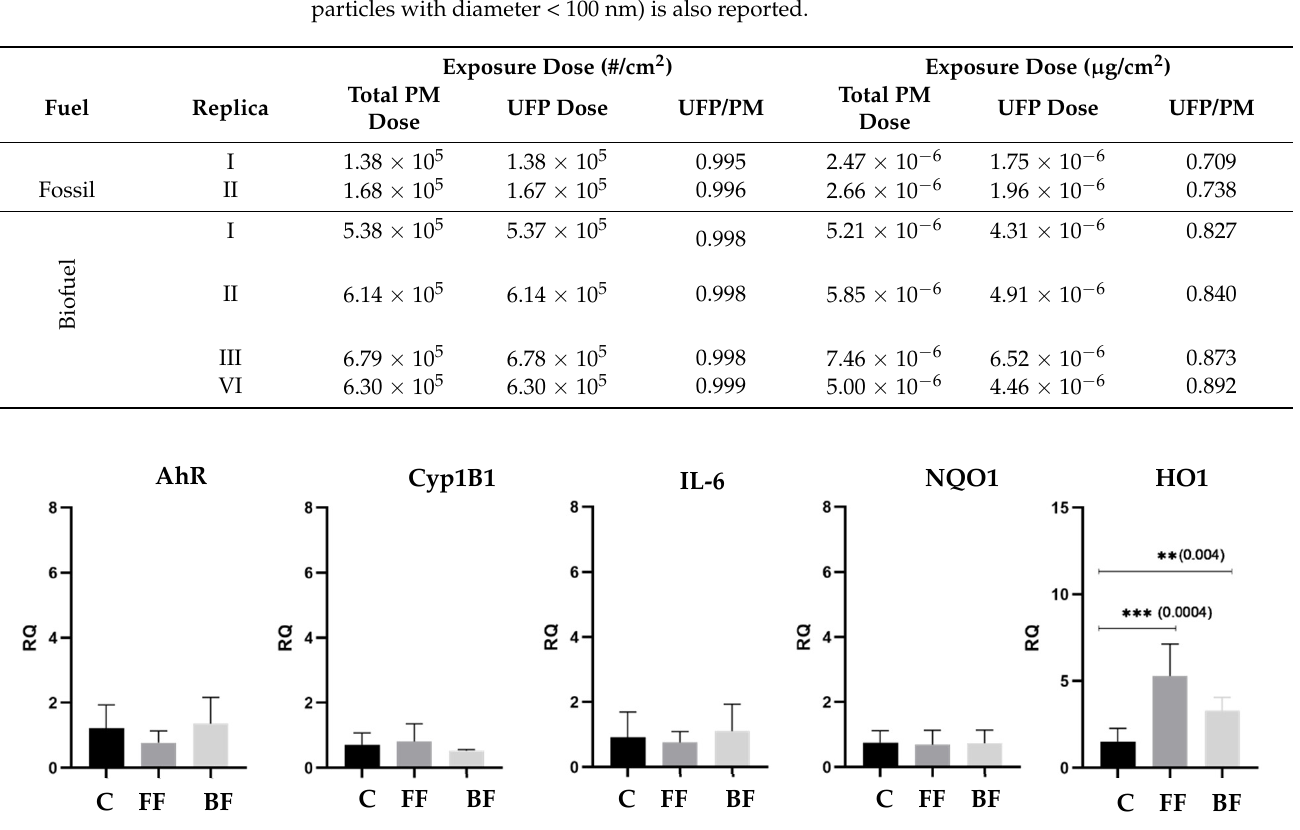
Table 9. Deposited doses of particles during emission tests and during background monitoring. Data are reported as deposited mass (µg/cm 2 ) of trachea–bronchial (TB) or pulmonary (P) epithelial surface.